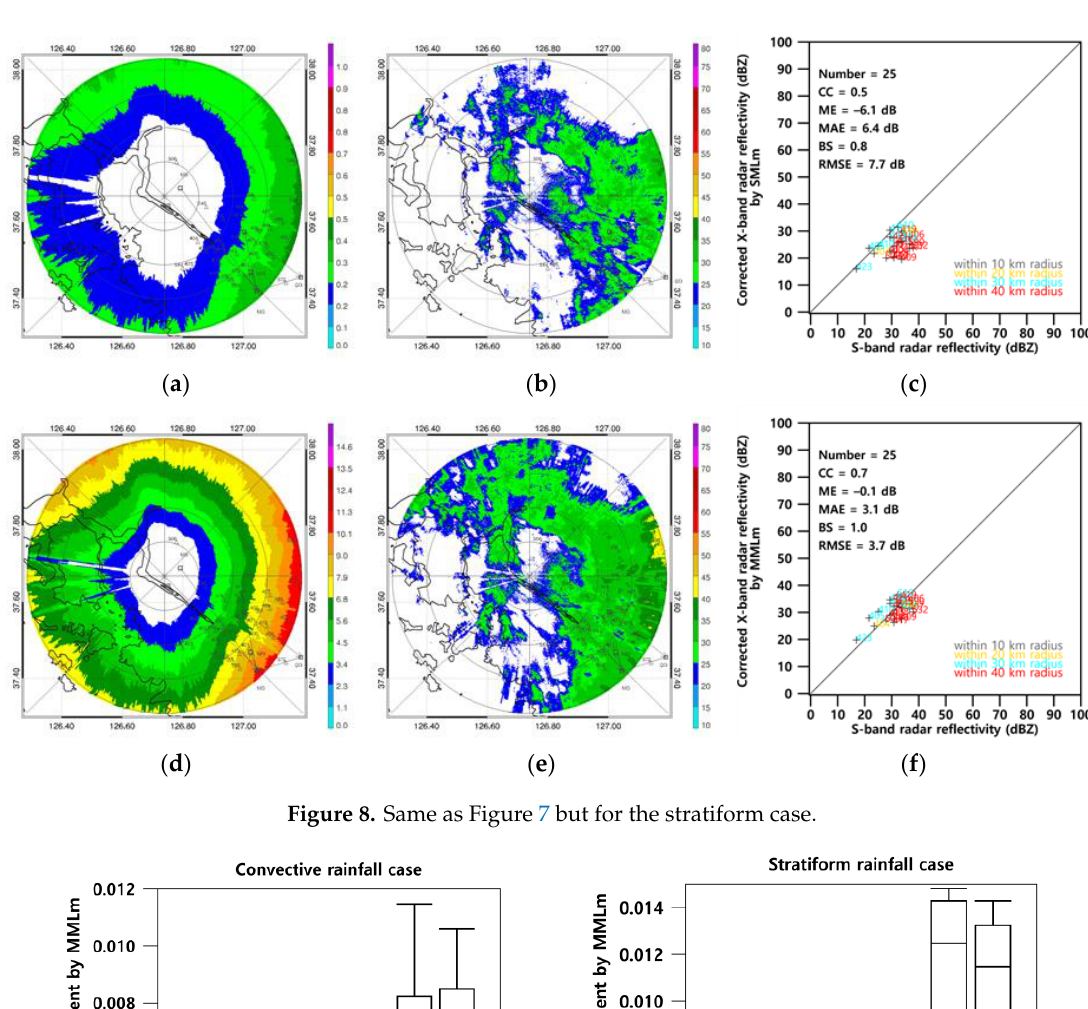
Figure 8. Same as Figure 7 but for the stratiform case.